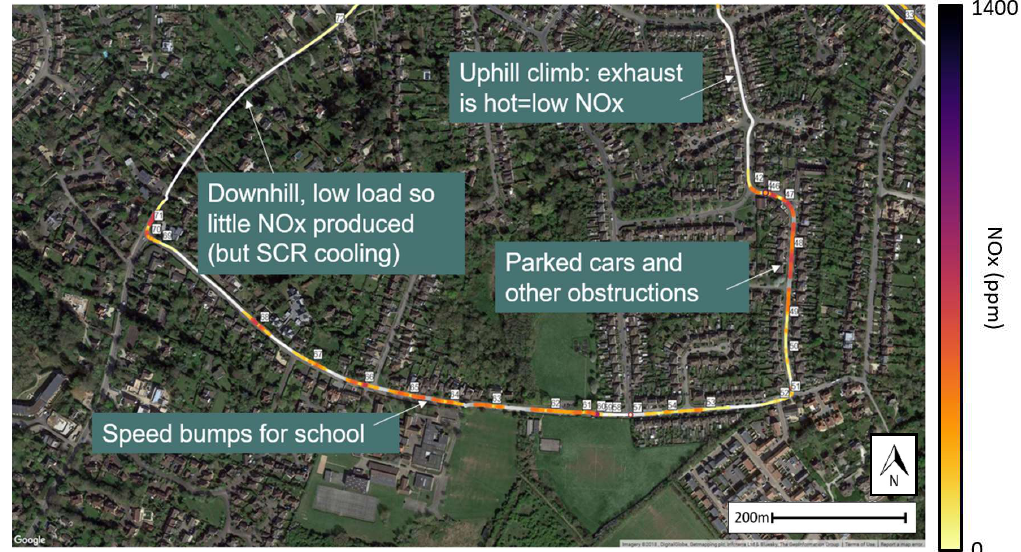
Figure 18. Euro V bus drop off at a school with associated NO x emission events.